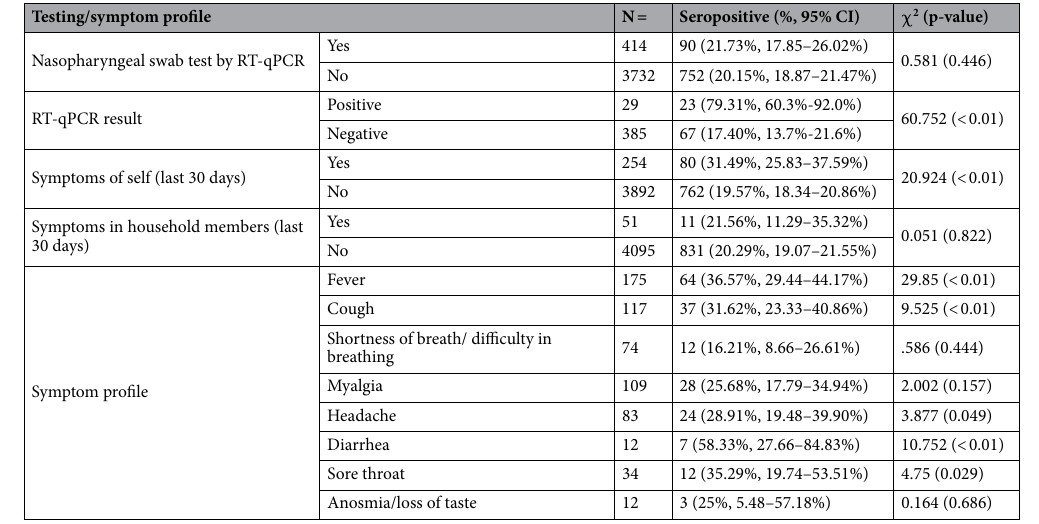
Table 2. Testing status and symptom profile of the study